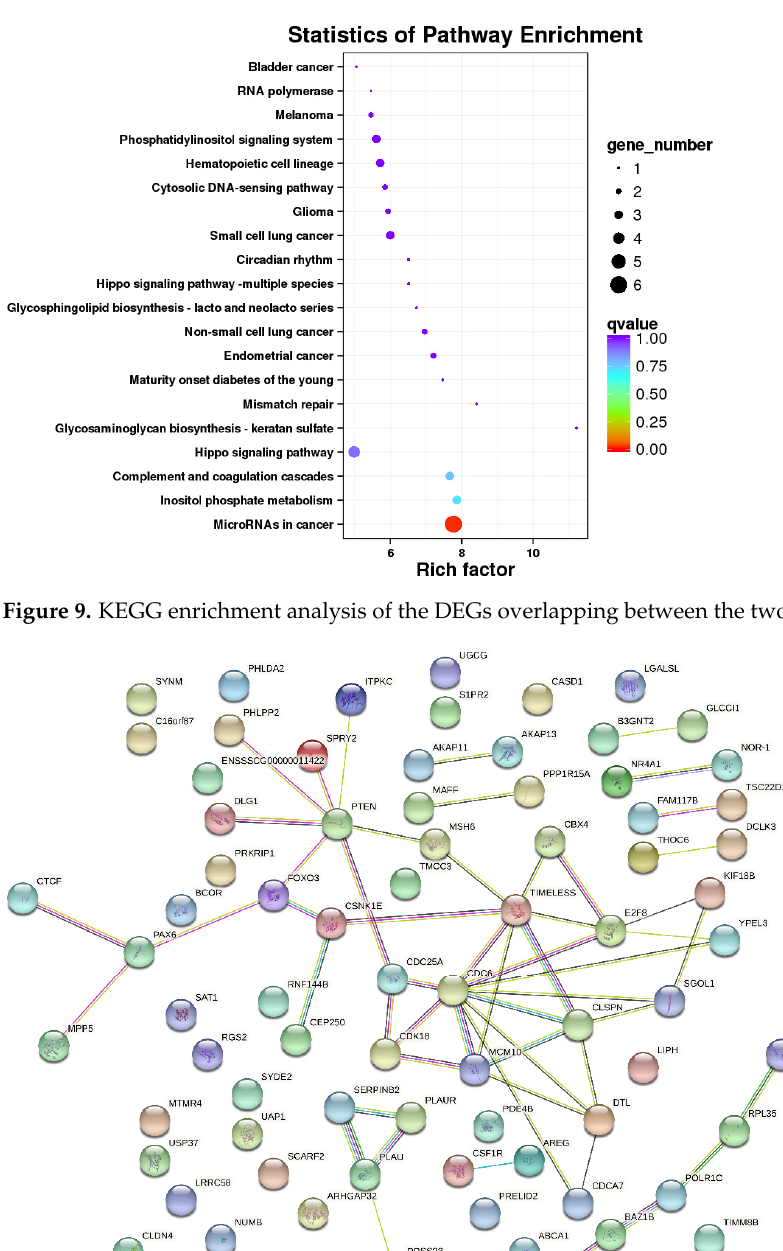
Figure 8. Overview of the DEGs after different treatments. ( A ) Venn diagrams of known DEGs based on comparisons of different groups. ( B ) Hierarchical clustering of the overlapping DEGs among different groups. The red indicates upregulated genes and the blue indicates downregulated genes.